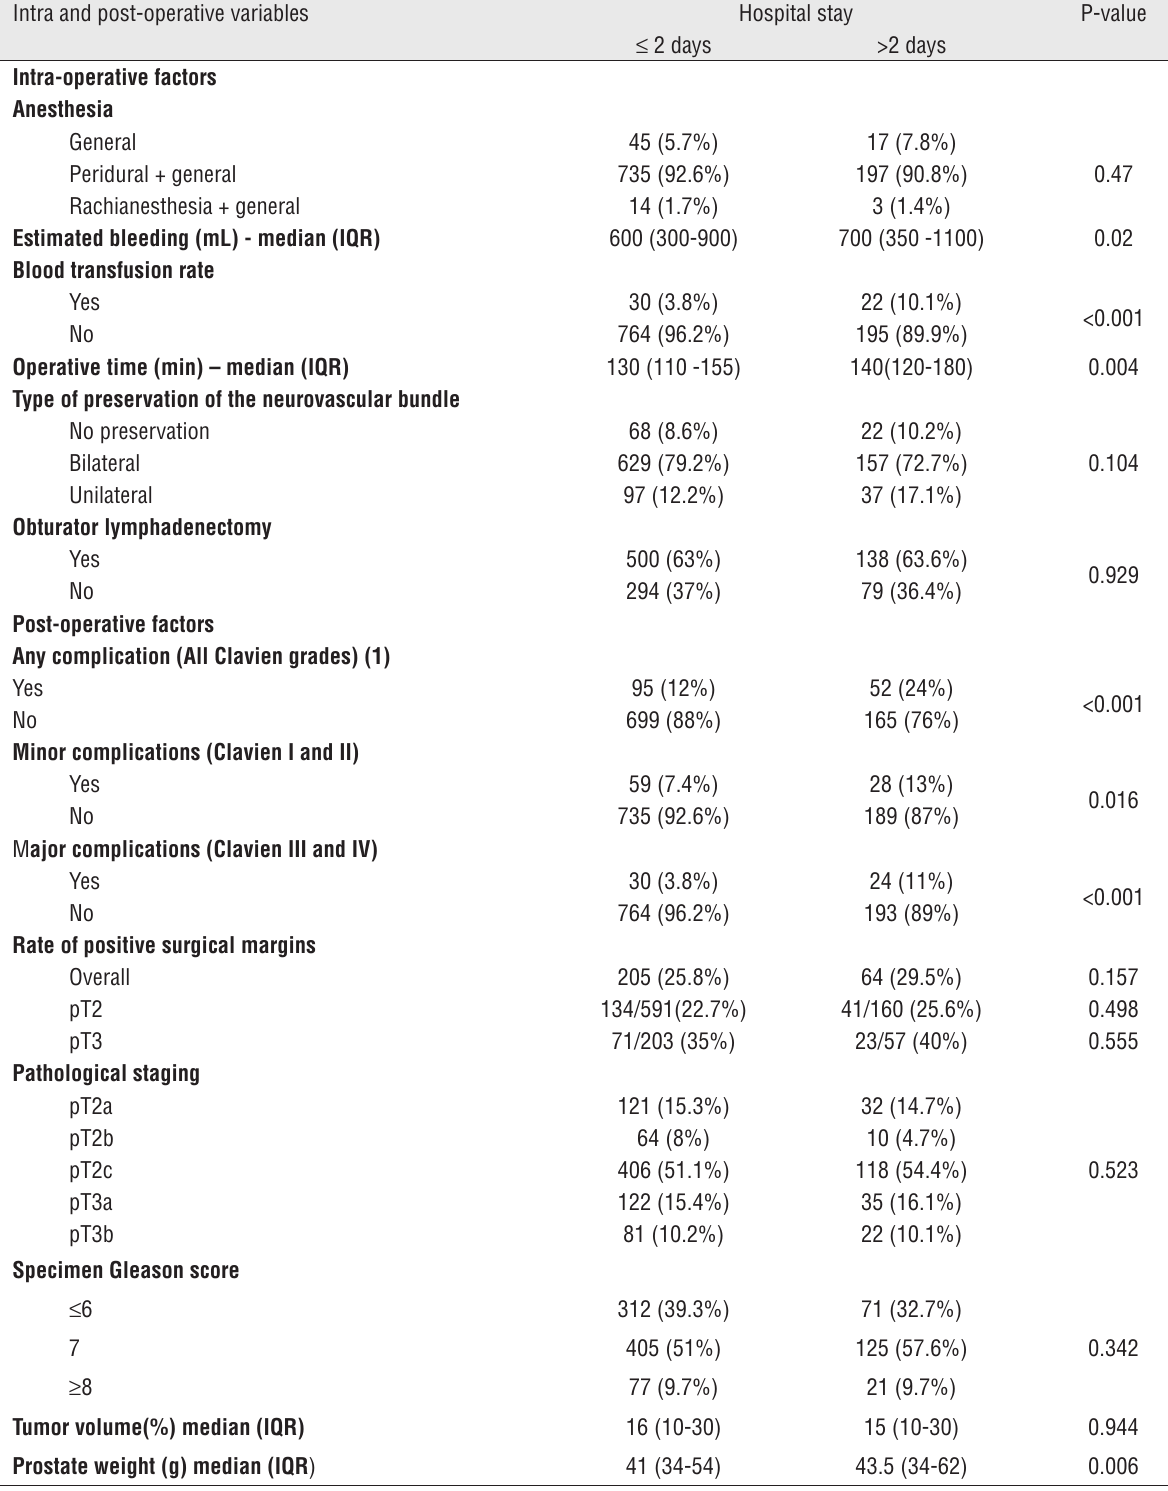
Table - 6B) Univariate analysis – Predictors of prolonged hospitalization amongst intra and post-operative variables. Intra and post-operative